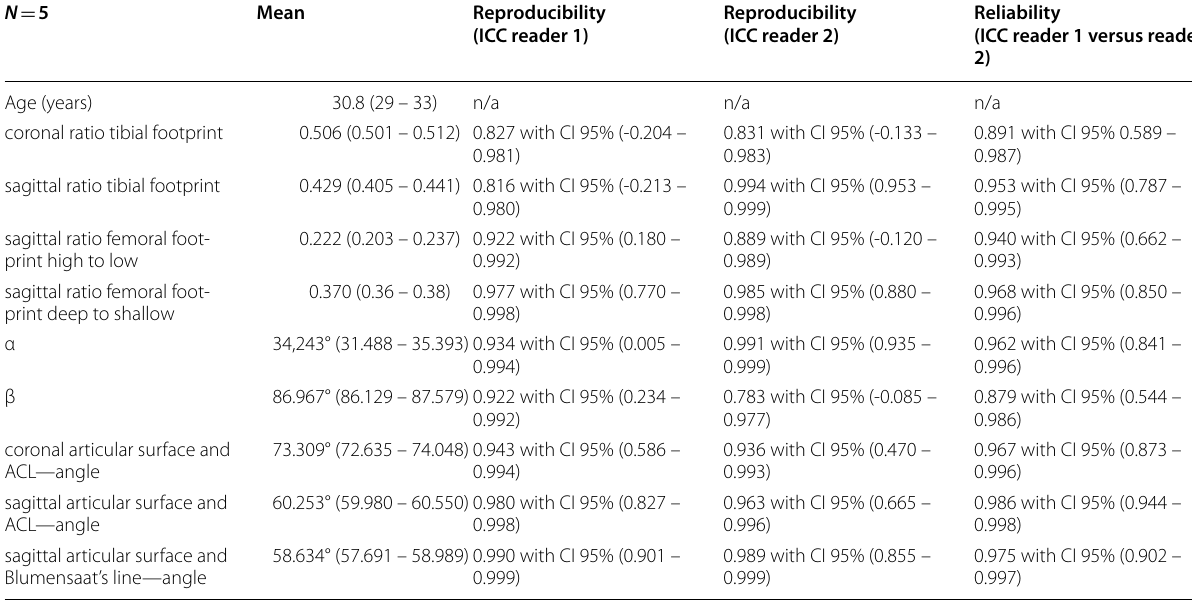
Table 1 Intra and interobserver measurement